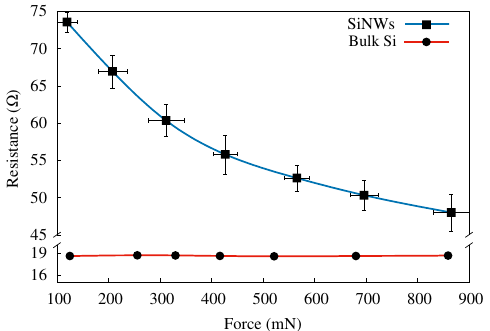
Figure 5. Resistance vs. applied force for the D-like samples (blue line) and bulk-Si (red line). Data for SiNWs are average values of four distinct samples; the error bars show the range in which the measurements fell.